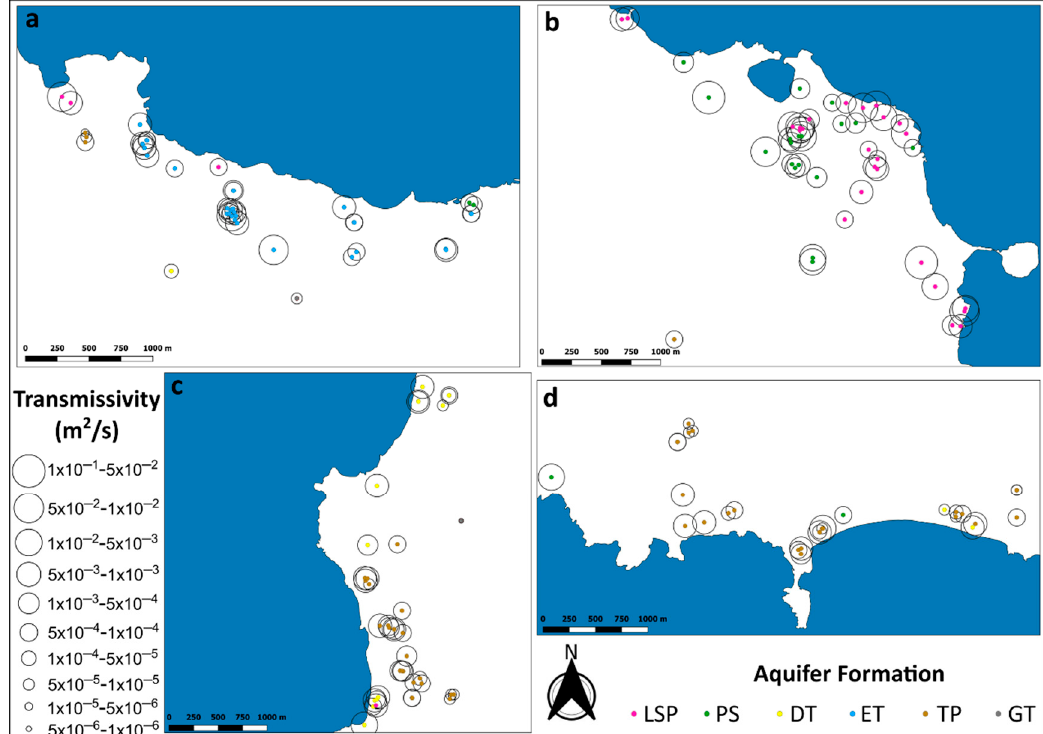
Figure 6. Distribution of wells with associated value of transmissivity and type of aquifer formation (for the abbreviations see the text, GT: Green Tuff of the central block of Mt. Epomeo): ( a ) N area, ( b ) NE area, ( c ) W area, ( d ) SW area.